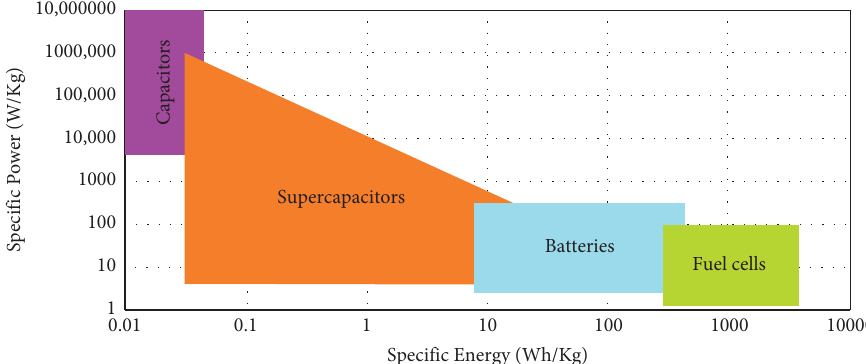
Figure 1: Specifc power as well as energy of a variety of